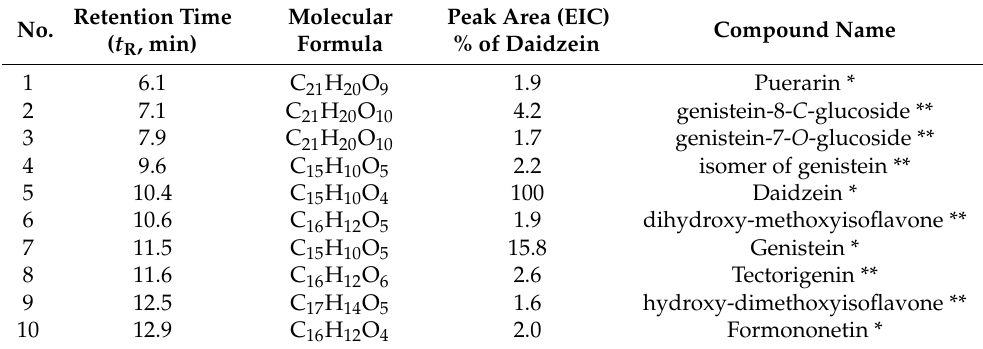
Table 3. Major isoflavones identified in the extract of KR using HPLC-ESI-HRMS. Retention Time Molecular Peak Area (EIC) No. ( t R , min) Formula